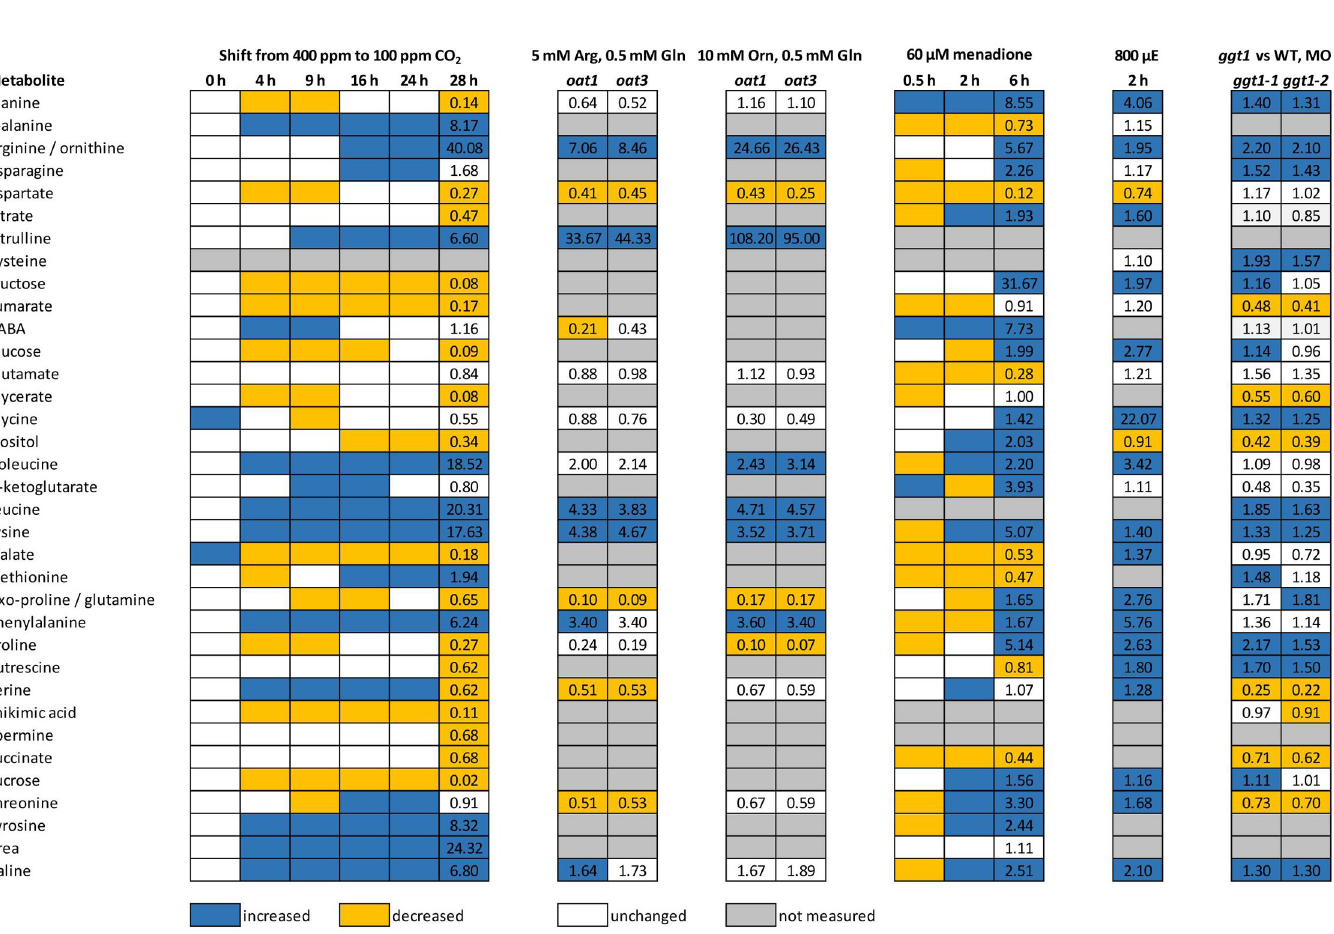
Fig 6. Comparison of metabolite changes in response to different stresses and in different Arabidopsis mutants. Data listed were extracted from publications by Funck et al. [7] ( oat mutants in response to nitrogen limitation), Florez-Sarasa et al. [29]) (high light treatment), and Dellero et al. [30] ( ggt1 mutant). Significant metabolite changes were determined by Student’s t-test ( p < 0.05) in our study and the selected publications, respectively. Numbers in selected columns indicate fold-changes relative to the control conditions. Given that Funck et al. [7], Florez-Sarasa et al. [29] and Dellero et al. [30] provided data for both arginine and ornithine, these fold changes were averaged in order to make them comparable to our GC-MS metabolite data. oat : T-DNA insertion in the gene encoding Arabidopsis ornithine- δ -aminotransferase, Arg: arginine, Gln: glutamine, Orn: ornithine, h: hours, ggt1 : T-DNA insertion in the gene encoding Arabidopsis glutamate:glyoxylate aminotransferase 1, MOD: middle of the day. Blue: significantly induced, orange: significantly reduced, white: unchanged, grey: not measured.